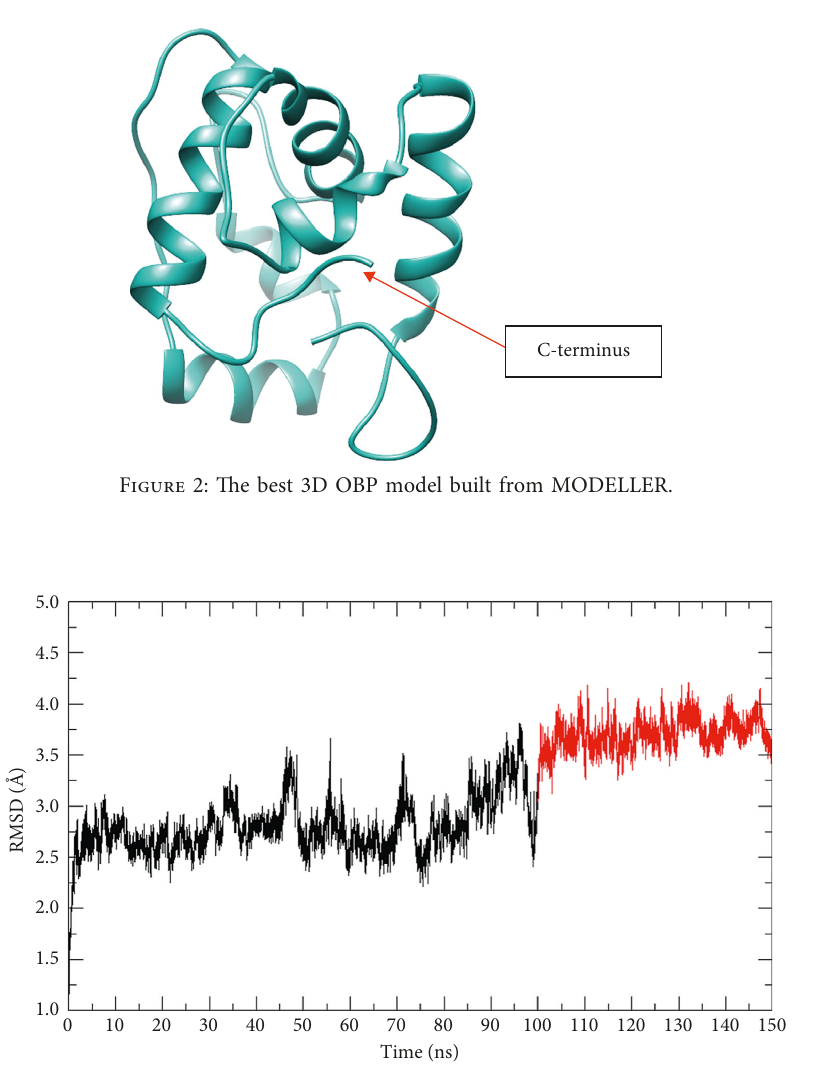
Figure 3: Root mean square deviation (RMSD) of the 150ns trajectory in MD